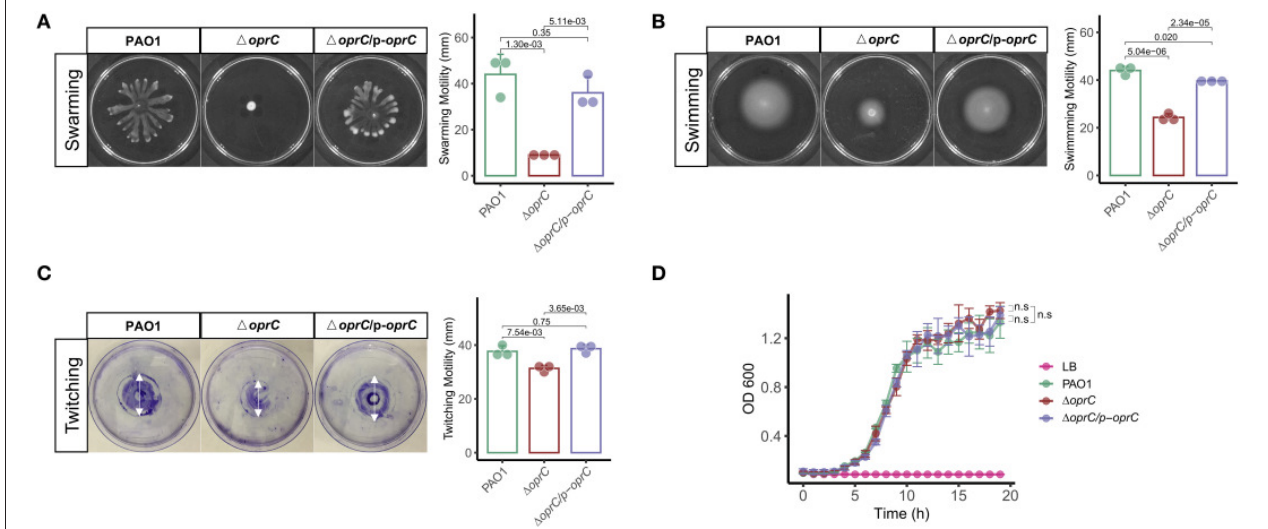
FIGURE 1 | Altered bacterial motility in the 1 oprC strain. After the bacteria were incubated at 37 ◦ C for 24h, (A) swarming motility ( n = 3) and (B) swimming motility ( n = 3) were assessed in a BM2 plate containing 0.5% agar and an LB plate containing 0.3% agar, respectively. (C) Twitching motility ( n = 3) after incubating for 60h at 37 ◦ C. (D) Bacterial growth curves ( n = 4) on LB media are shown. Error bars represent the mean ± s.d. Kolmogorov-Smirnov test was performed for bacteria growth curves analysis. One-way ANOVA with a post-hoc Tukey test was performed for comparison of means of groups in other cases.